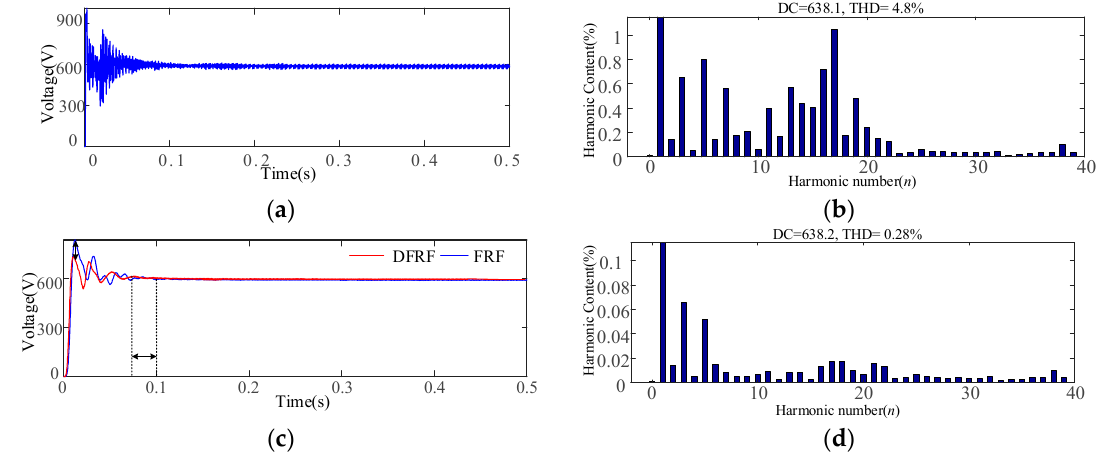
Figure 17. Simulation results for different filters: ( a ) Filtering waveform of TF; ( b ) Voltage spectrum of TF; ( c ) Filtering waveforms of DNMFRF and FRF, and ( d ) Voltage spectrum of DNMFRF and FRF.